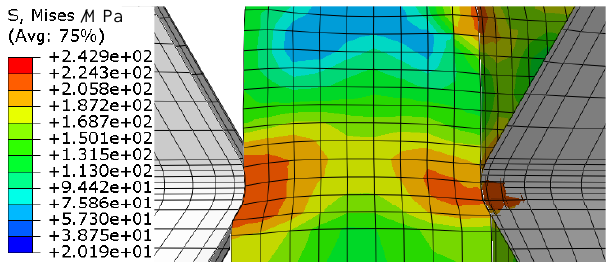
Figure 17. The stress nephogram of the tube deformation region in 10% thickness reduction SCRFF process.